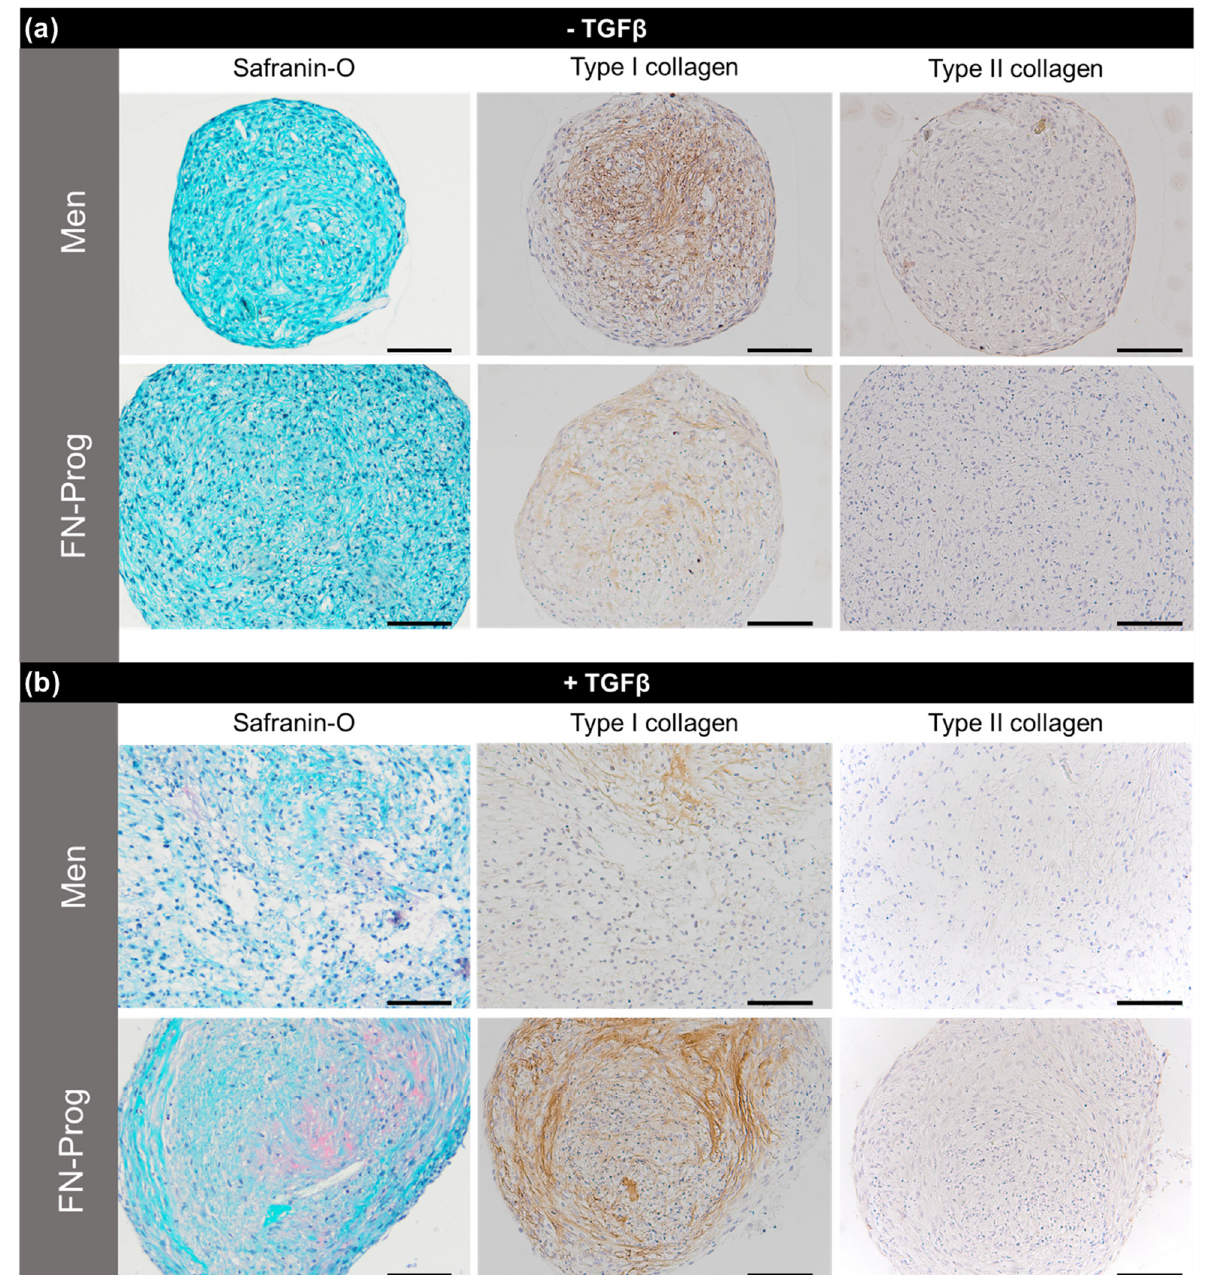
Figure 5. Representative sections of pellets cultured for 28 days in differentiation medium in ( a ) absence of TGF- β 1 or ( b ) presence of TGF- β 1. n = 5 donors per group per condition. Scale bars represent 100 µm.